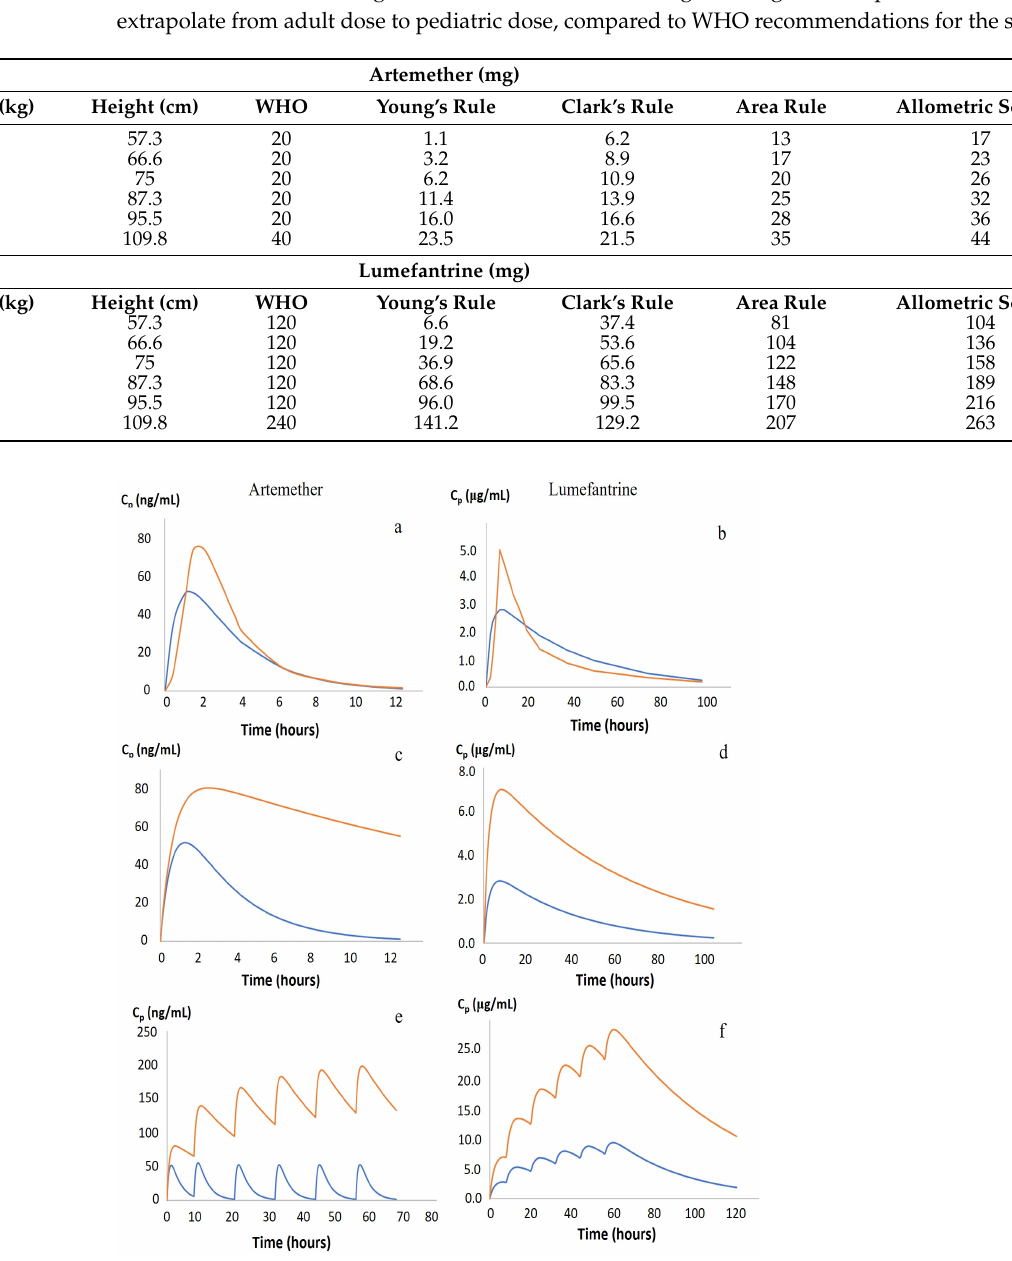
Figure 2. Plasma concentration profiles of artemether and lumefantrine. ( a , b ) The calculated phar- macokinetics in adults (blue) in comparison with real adult data based on the pharmacokinetics of Coartem ® , from Novartis (orange). ( c – f ) The pharmacokinetics in adults (blue) and a 5 kg child (or- ange), using pharmacokinetic values from the literature and dosed according to the guidelines from the World Health Organization. ( c , d ) A single dose administration of artemether ( c ), and lumefan- trine ( d ). ( e , f ) The appearance of full treatment when doses are administered at time 0, 8 h, then every 12 h for 3 days for artemether ( e ), and lumefantrine ( f ).